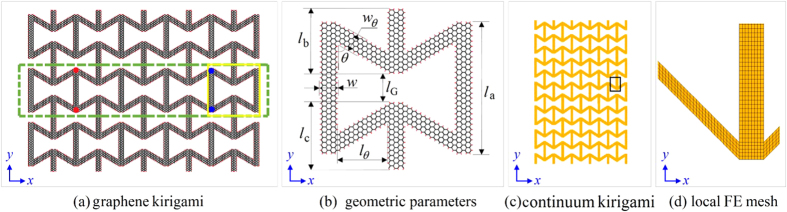
Schematic of a graphene kirigami with detailed geometric parameters.(a) The atomic system with periodic microstructure. (b) Geometry of local microstructure (in the solid yellow frame in (a)) with detailed geometric parameters of the kirigami. The microstructure has one more vertical rod than the unit cell. (c) The finite element model of the continuum kirigami. (d) The local finite element (FE) mesh in the solid black frame in (c).